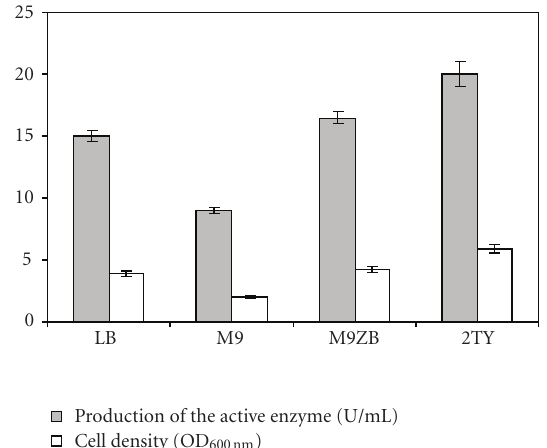
Figure 6: SDS-PAGE analysis of the purified US132 CGTase from the recombinant E. coli ER2566/pSJ8 strain. Lane 1: purified US132 CGTase, Lane 2: molecular weight